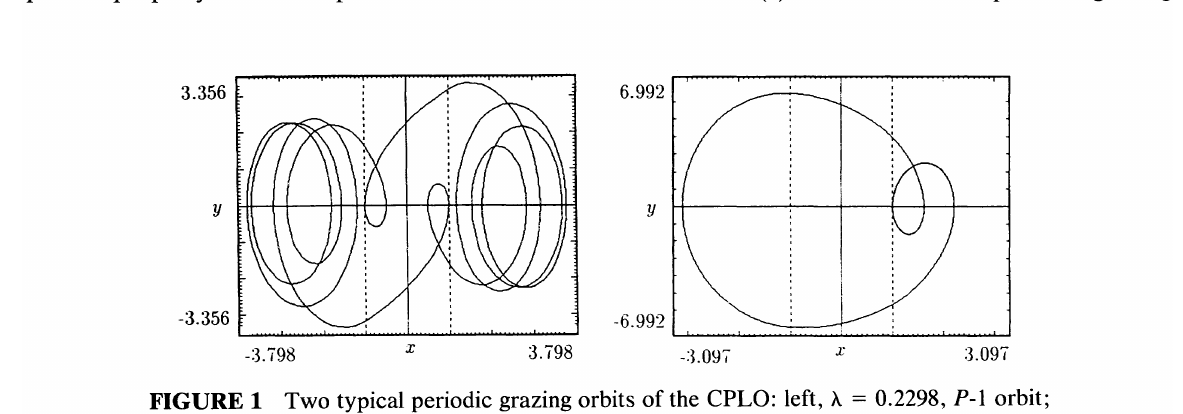
FIGURE 1 Two typical periodic grazing orbits of the CPLO: left, A = 0.2298, P-l orbit; right, A = 3.372, P-2